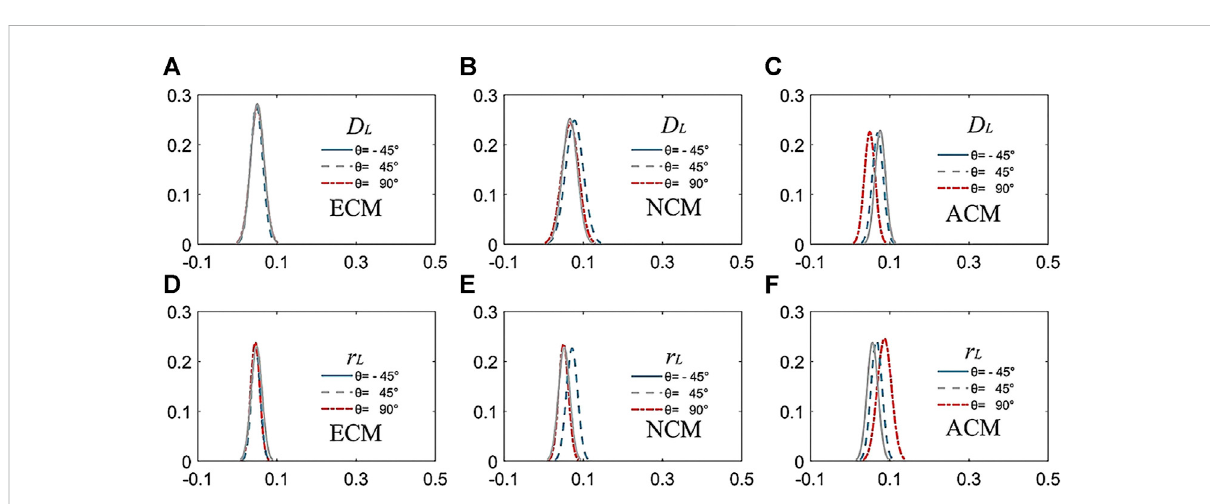
FIGURE 6 Frequency distribution images of different rotation invariant indicators, (A – C) rotation invariant indicator D L , (D – F) rotation invariant indicator r L